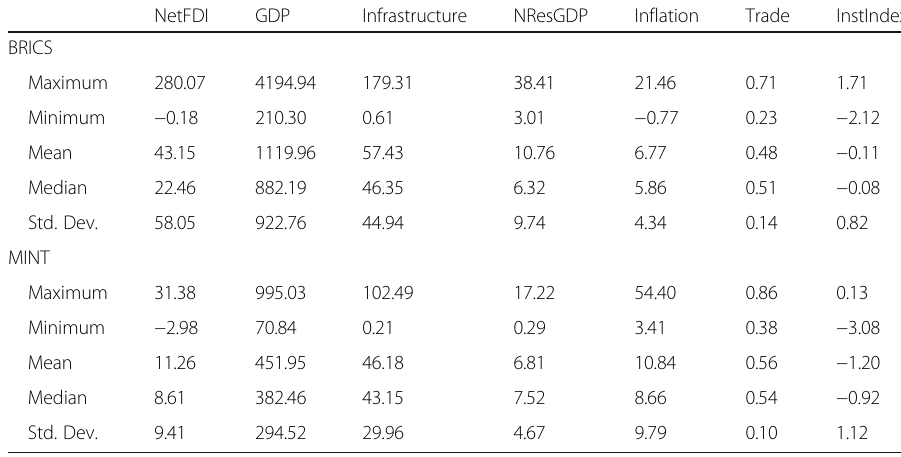
Table 5 Descriptive statistics of the variables used in the analysis NetFDI GDP Infrastructure NResGDP Inflation Trade InstIndex BRICS